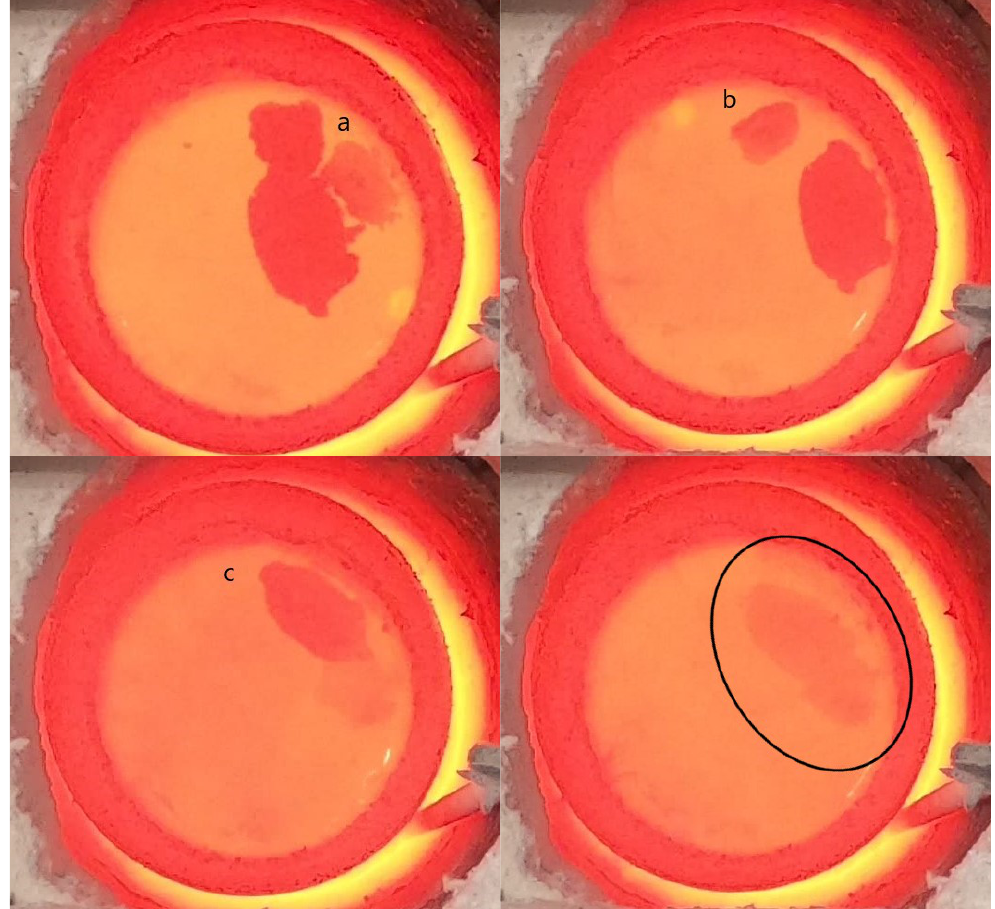
Figure 11. Images of descending subrafts ( a – c ) of bulk alumina type A, denoted in Figure 10. In the last frame, it is possible to see the descended rafts on the bottom of the